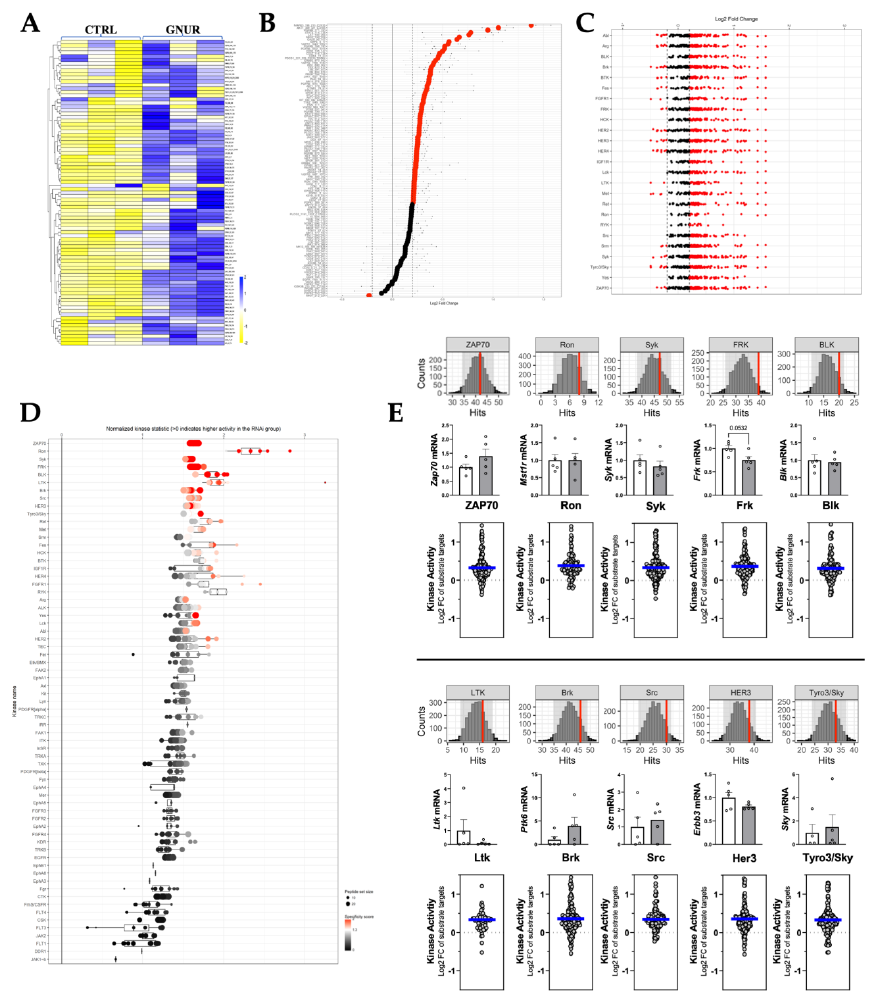
Figure 5. Phospho-tyrosine kinase (PTK) PamGene kinome activity analysis. ( A ) Heatmap analysis of differential PTK substrate phosphorylation. ( B ) Waterfall plots are shown by log fold change of substrate phosphorylation. ( C ) Differentially phosphorylated substrates mapped back to responsible kinases (upstream analysis) by reverse KRSA analysis. ( D ) Waterfall plot of individual kinases. ( E ) Peacock plots (confidence measure indicated by the red line), mRNA measurements, and MEOW plots for the top kinases. The STK analysis showed a general hypophosphorylation across assayed substrates shown in the heatmap and waterfall plot analysis (Figure 6A,B), as also shown in the re- verse KRSA plot (Figure 6C) and for individual kinase activity in the upstream STK wa- terfall plot (Figure 6D). We further quantitated peacock plots of the top targets changed